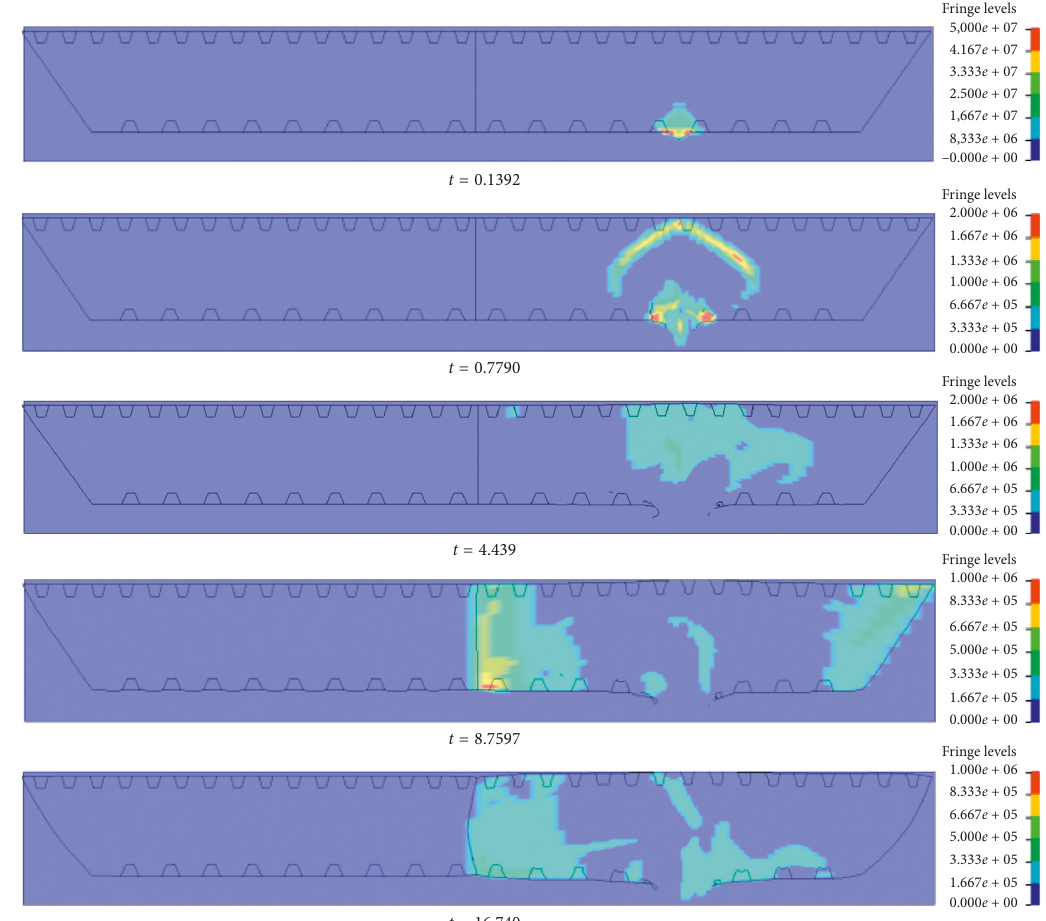
Figure 7: Pressure evolutions of explosion in position 2 (middle cross section, time unit: